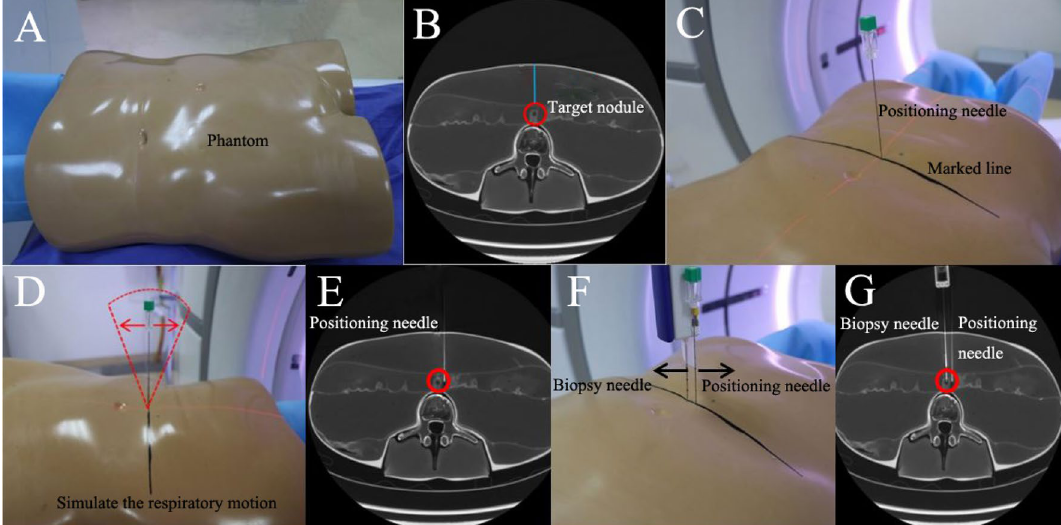
Figure 2. Schematic of a fine needle-mediated breathing control puncture for biopsy, illustrated by a body phantom ( A ). ( B ) The phantom was CT scanned to show the target nodule (red circle) and puncture path (green line); ( C ) a 23G fine needle was vertically inserted with the help of laser light, and the project line of fine needle delineated (dark line); ( D ) The fine needle was simulating swinging with the breathing and was inserted in the vertical position; ( E ) the fine needle near the target nodule was showed in one transverse CT image to confirm the fine needle was seen in one slice image; ( F ) With the guidance of the fine needle, a biopsy needle was punctured; ( G ) both needles were verified by CT scan.